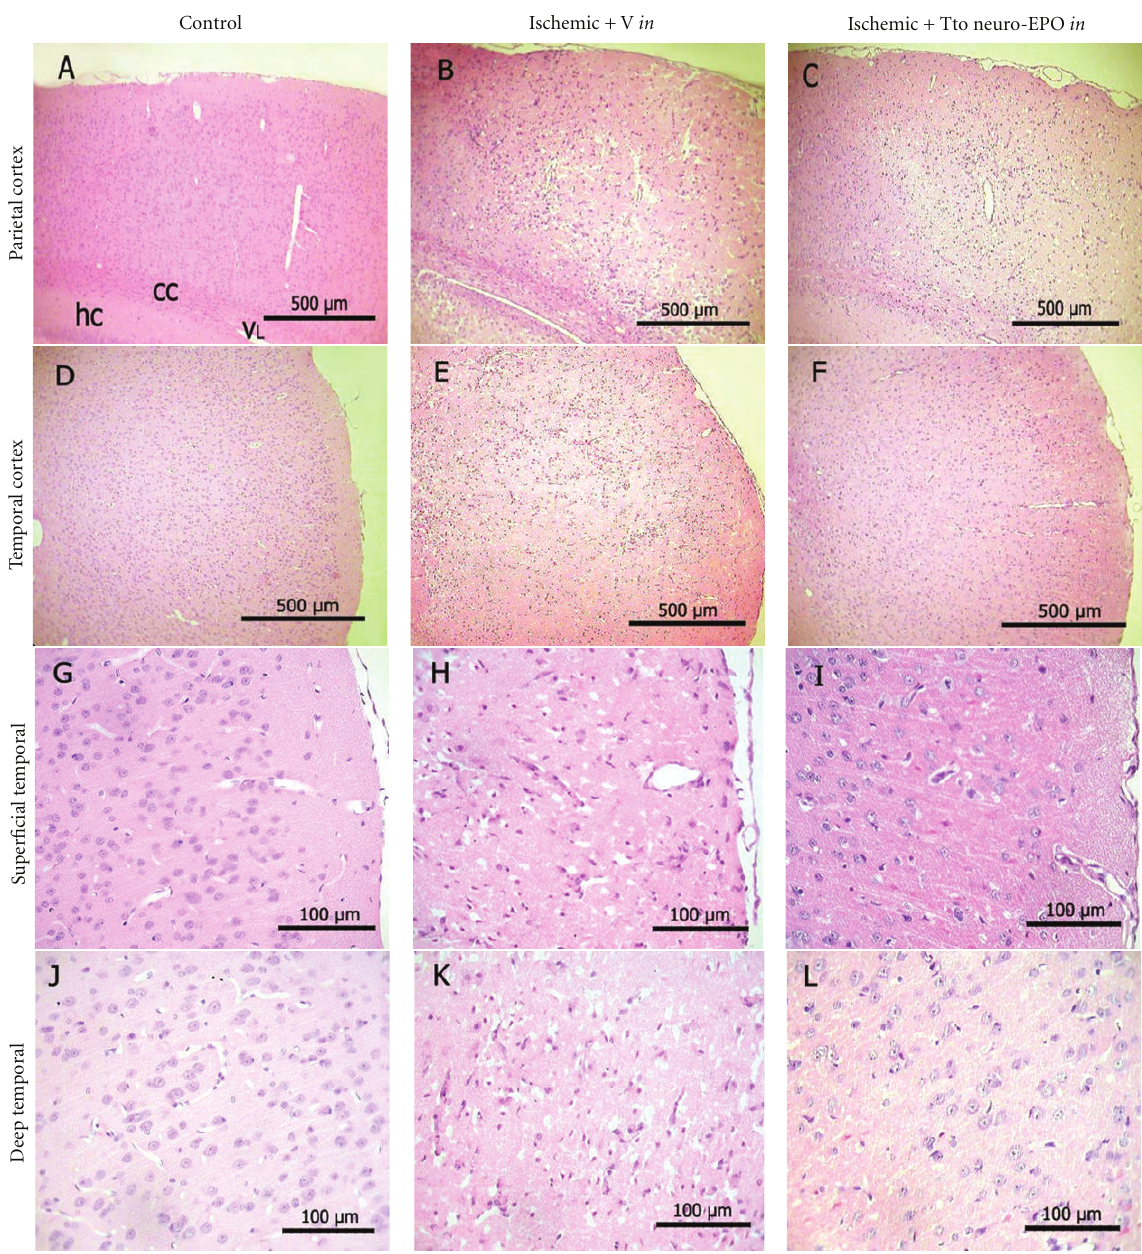
Figure 5: Model of focal ischemia. Parietal and temporal cortex. Unilateral ischemia produces infarction in the parietal cortices (B) and temporal (E, H, K). The Neuro-EPO rescues neurons in the temporal cortex (F, I, L). H-E. A, B, C: Panoramic view of the parietal cortex. hc: hippocampus; cc: corpus callosum; VL: lateral ventricle. D, E, F: A panoramic view of the temporal cortex. G, H, I: outer layers of the temporal cortex. H: Loss of the neural elements with holes. I: looks like the control. J, K, L: deeper layers of the temporal cortex. K: Loss of the neural elements with holes. L: looks like the